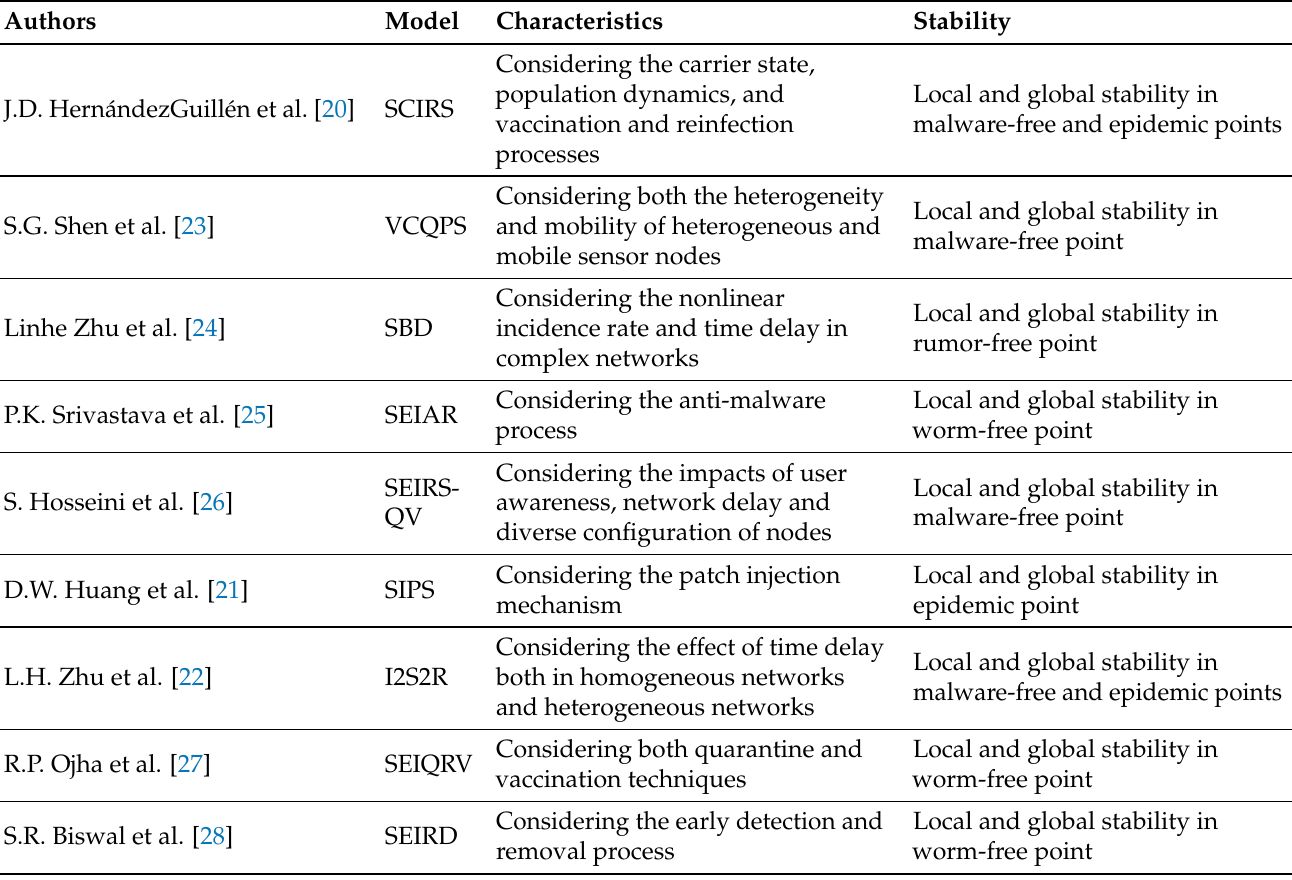
Table 1. Researches on stability of epidemic model in Wireless sensor networks